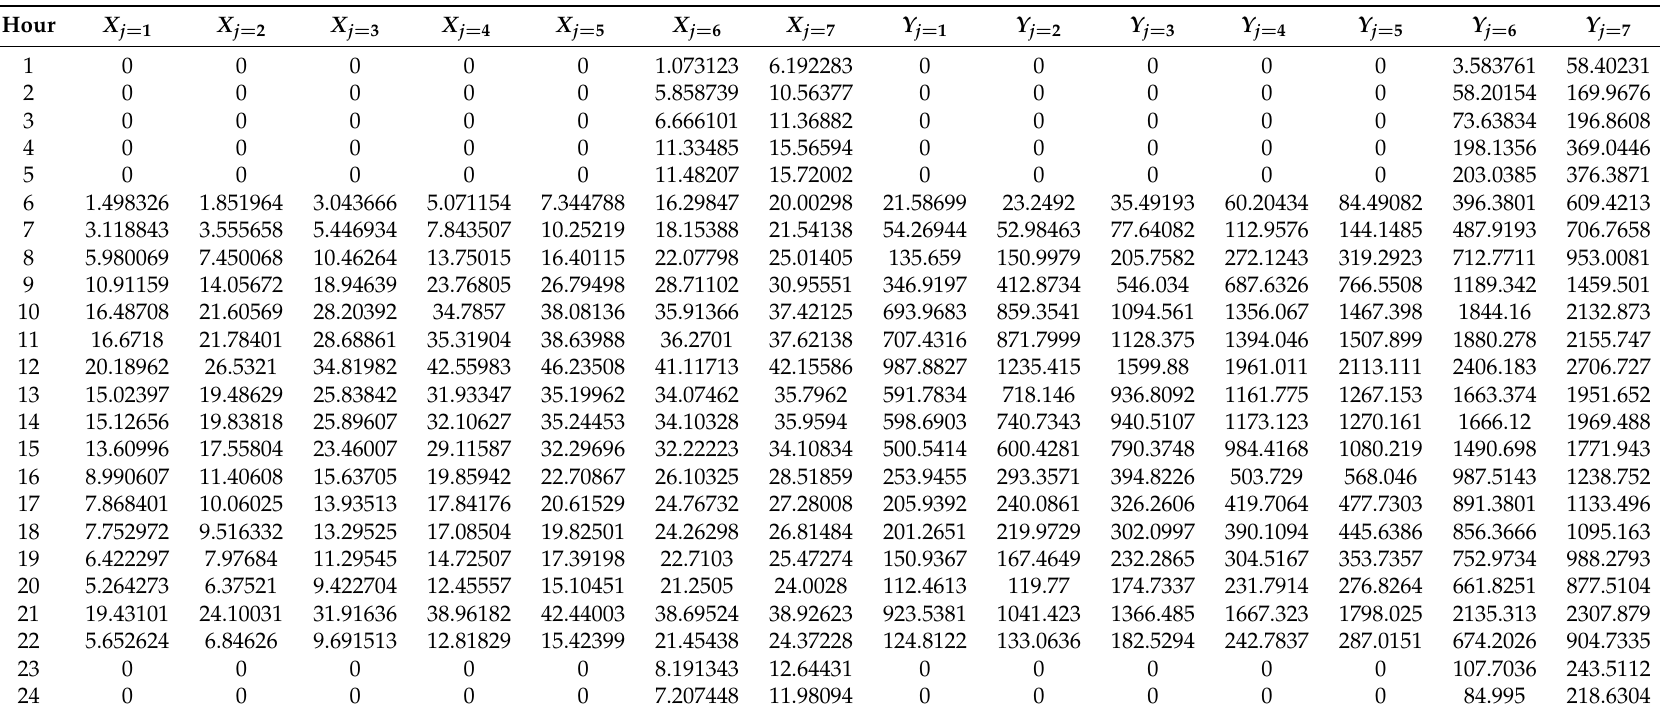
Table A6. Detailed demand response results for Case